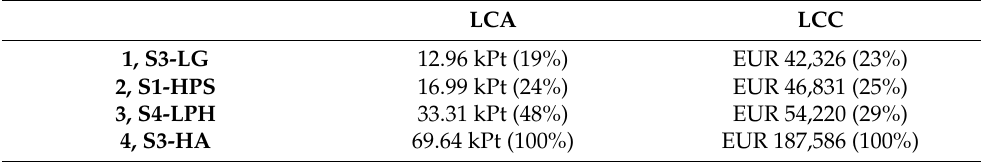
Table 12. Comparative analysis of environmental and economic